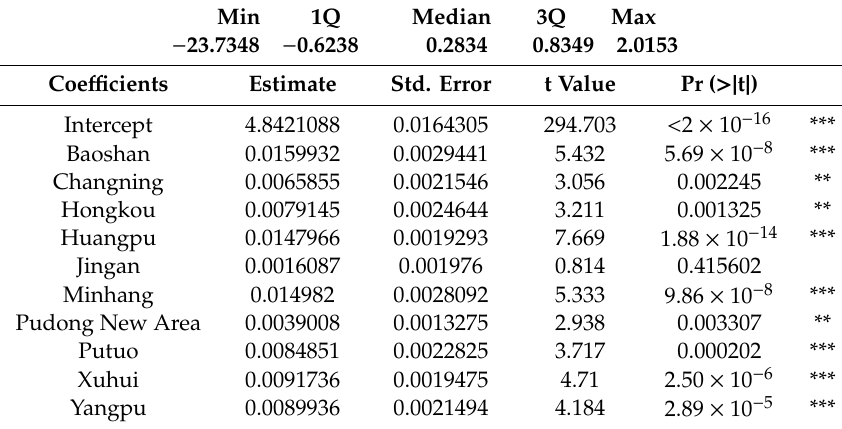
Table 3. Final multiple linear regression model interpretation.